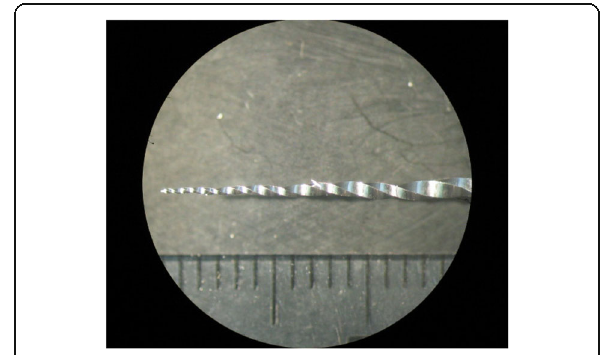
Fig. 2 Stereomicroscope imaging for protaper